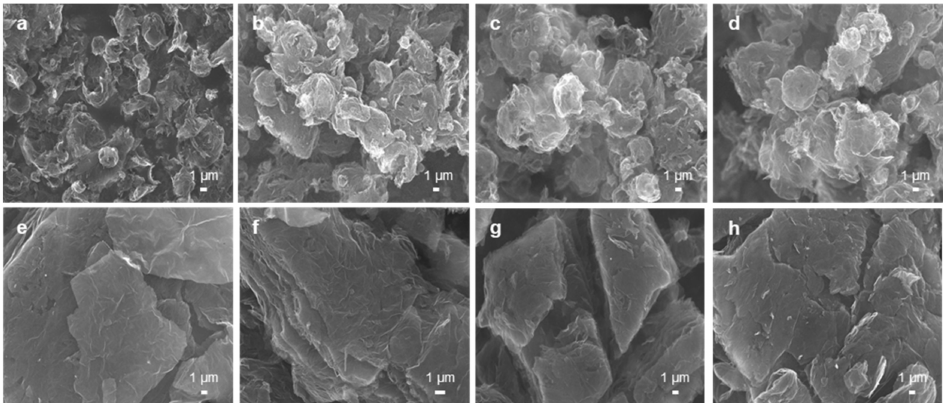
Figure 3. SEM images of ( a – d ) TGF600 and ( e – h ) V-50 reduced graphene oxide (rGO)